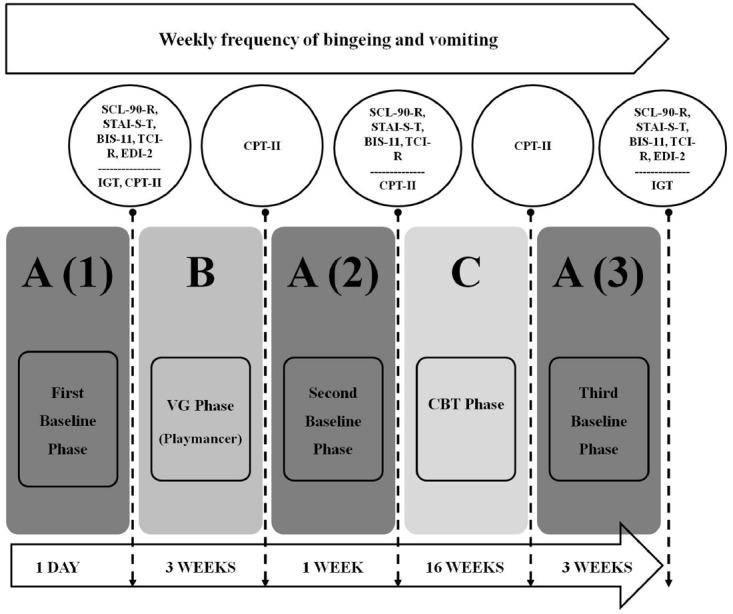
“A-B-A-C-A” design.